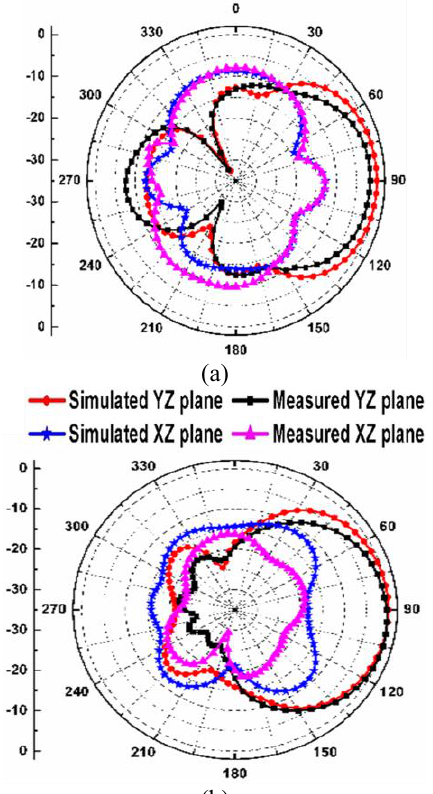
Figure 7: Radiation pattern in elevation plane for case 1